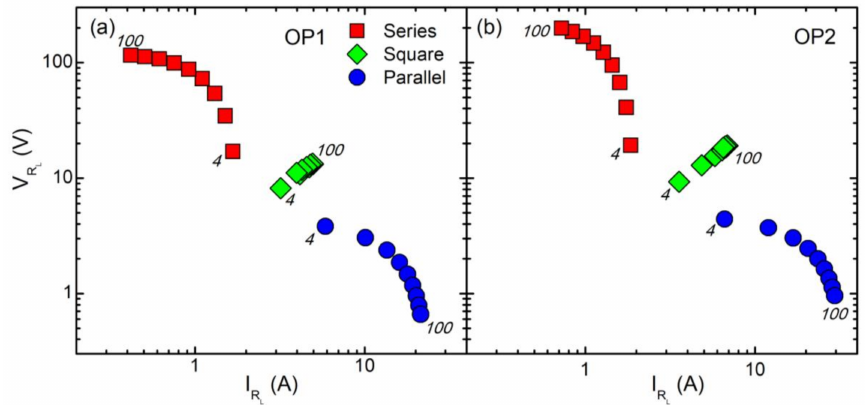
Figure 9. Voltage at the ends of the load resistance as a function of current through the load resistance at the maximum output power in ATEGs with different number of TEMs and using series, square and parallel configurations. Results under ( a ) operating point #1 and ( b ) operating point #2. Numbers in italics refer to the number of TEMs n TEM